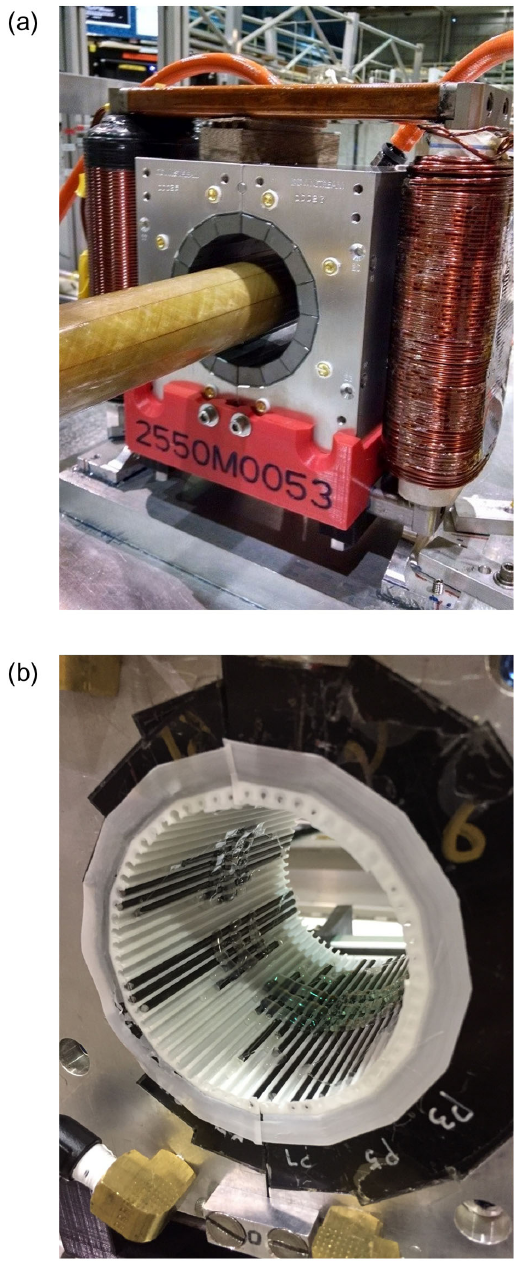
FIG. 9. (a) QD magnet being measured with a rotating coil at BNL magnet division. (b) BD magnet with tuning rod pack